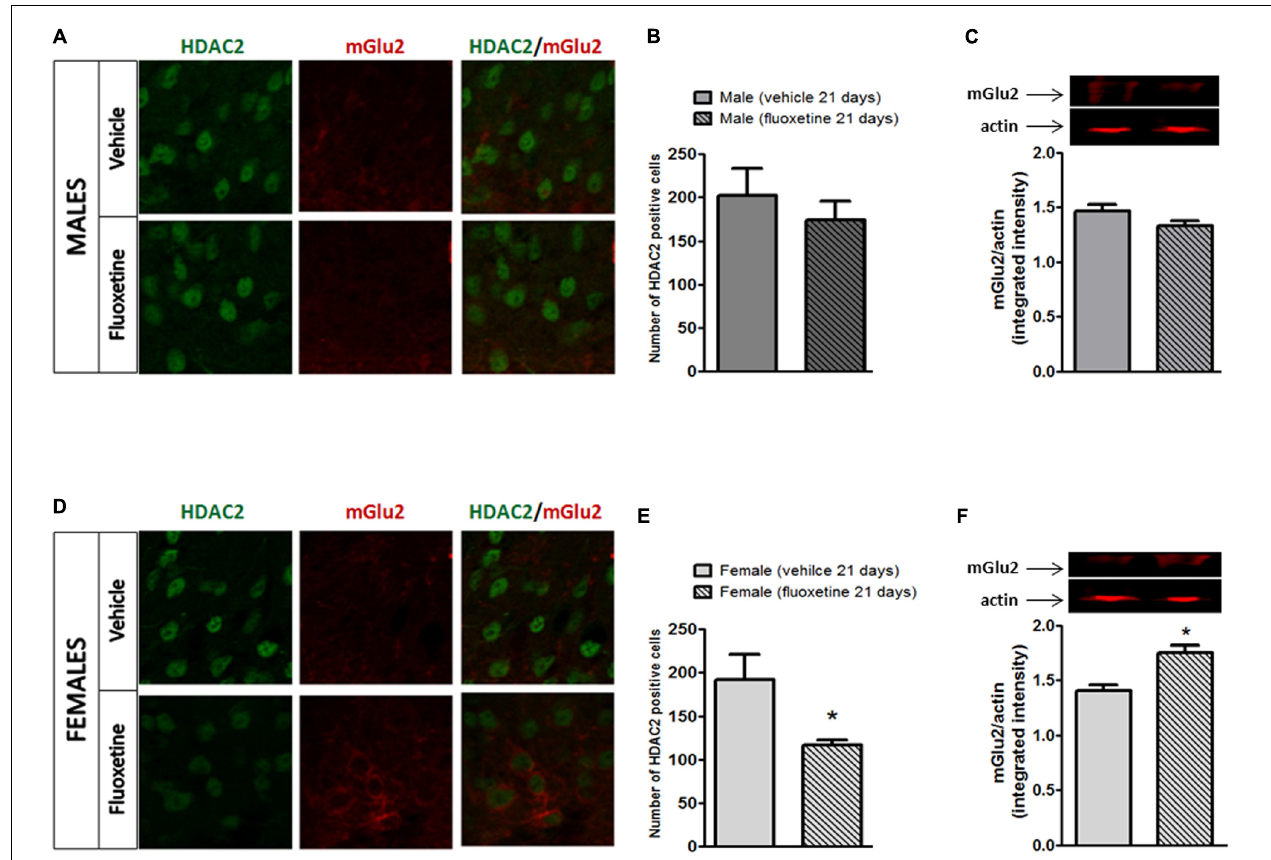
FIGURE 3 | Expression of HDAC2 and mGlu2 receptors in the lumbar dorsal horn of male and female mice after chronic administration with fluoxetine. (A,D) Representative examples of HADC2 positive cells (left column) and mGlu2 immunostaining (central column) or overlapping (right column) in the dorsal horn of the spinal cord in male and female mice after chronic treatment with fluoxetine. (B,E) Quantification of the cell density (cell number/area) for HDAC2 immunopositive cells. Bars represent average ± SEM. ∗ p < 0.05 (Student’s t -test) versus vehicle. (C,F) Densitometric analysis of mGlu2 bands normalized by actin. Data are the means ± SEM of five animals. ∗ p < 0.05 (Student’s t -test) versus values obtained in animals of the same sex treated with